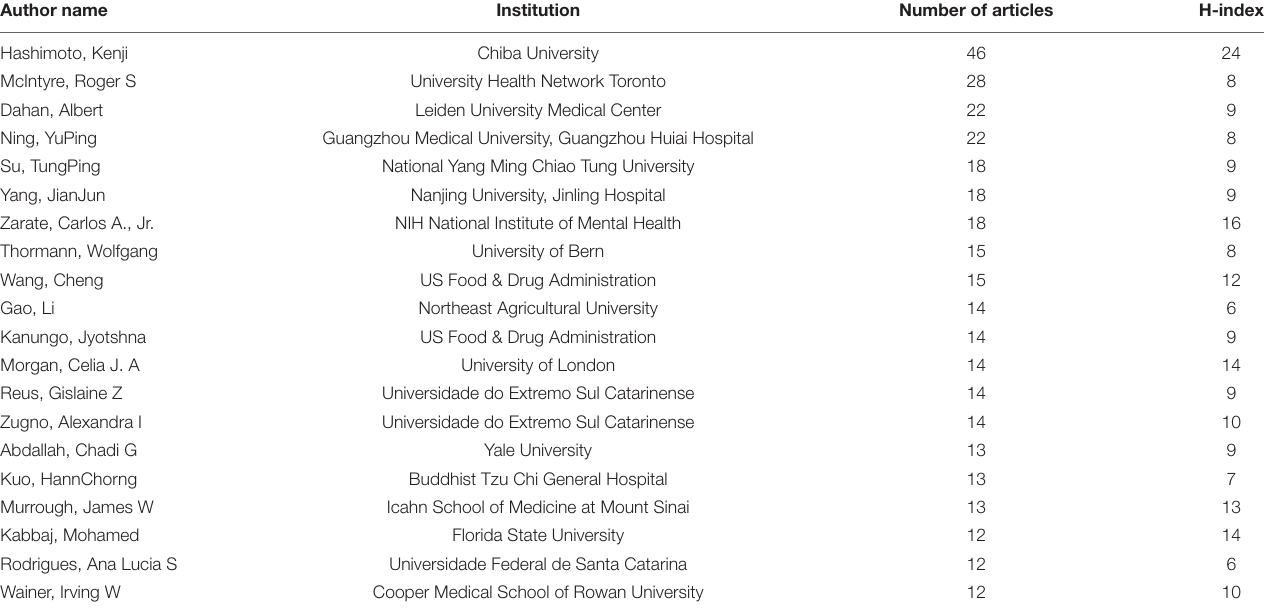
TABLE 2 | The 20 authors with the highest number of publications.